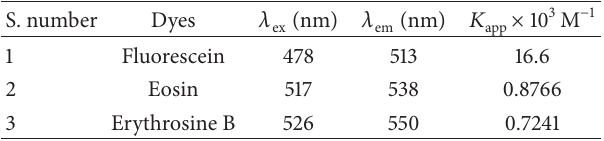
) and emission ( 𝜆 ) wavelengths of the xan- ex em ) from fluores- app 2